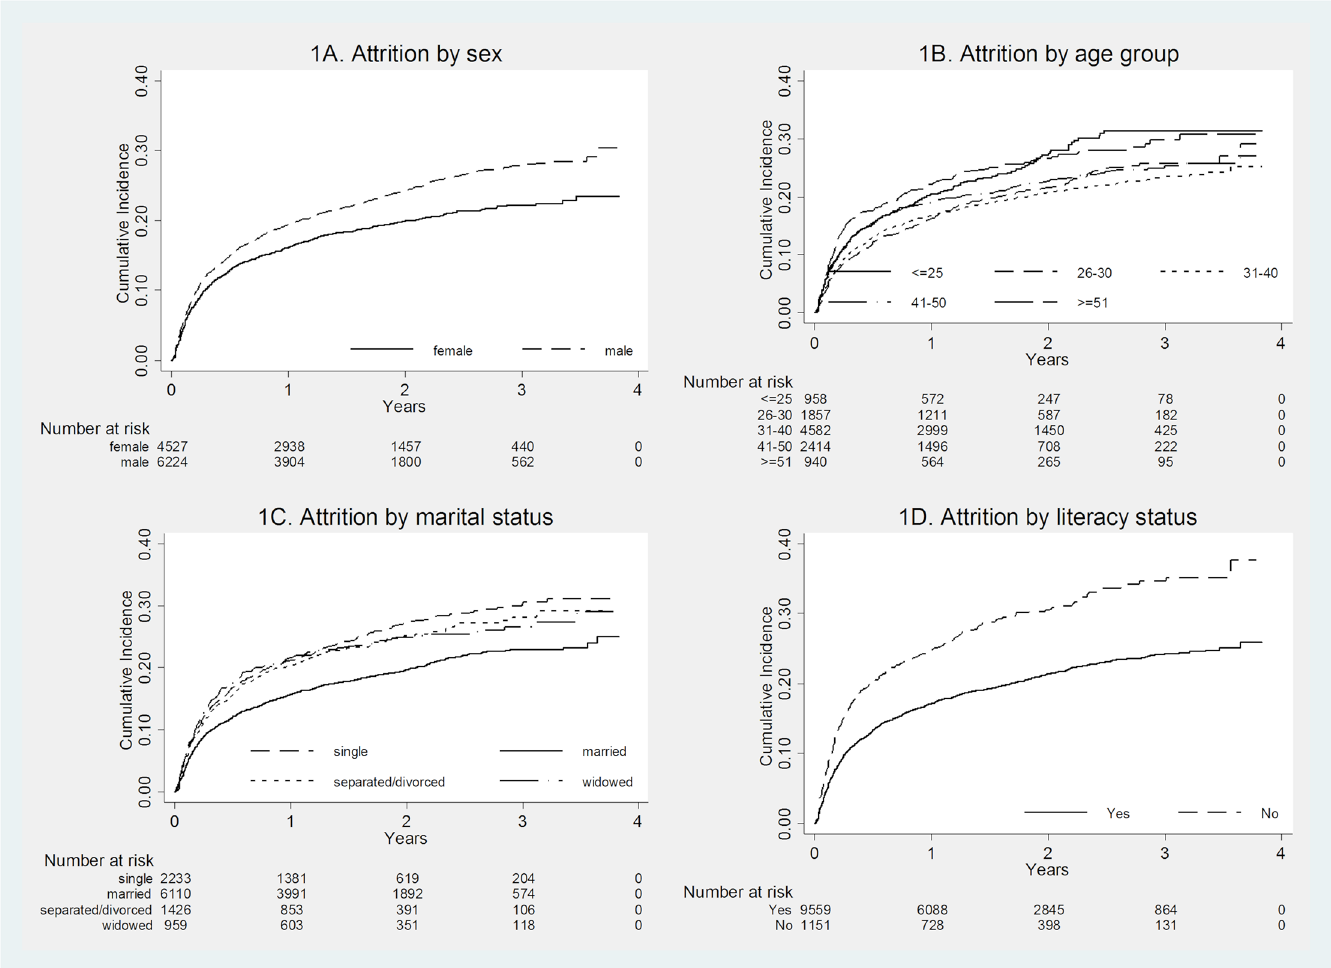
Fig 1. Cumulative incidences of attrition after ART initiation of adult PLHIV in three hospitals specializing for HIV care in Myanmar, 1 st June 2013 to 30 th June 2016. ART, anti-retroviral therapy; HIV, human immunodeficiency virus; PLHIV, people living with HIV.